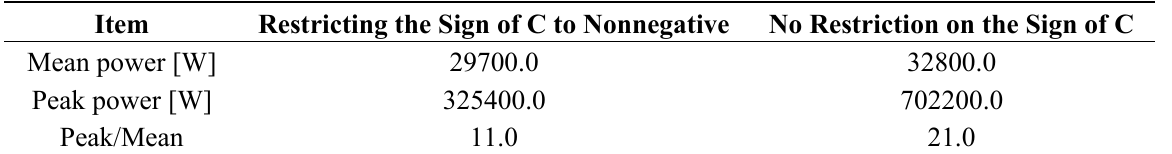
= 2.0 m, (cid:1846) = 5.24 s. (cid:3046) (cid:3043)